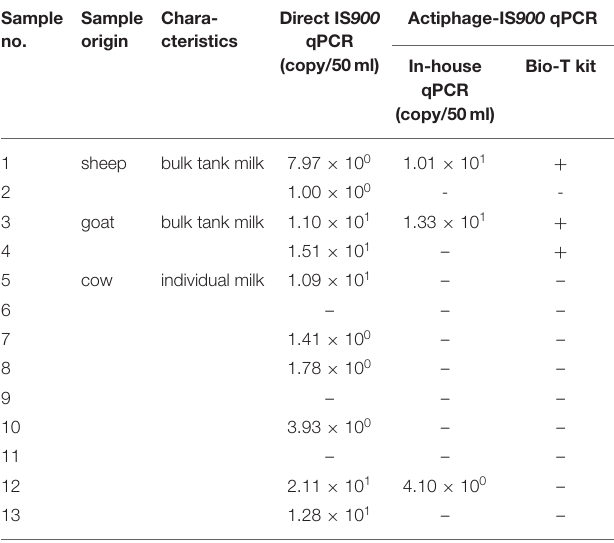
TABLE 2 | Comparison of the Actiphage-qPCR assay with direct IS 900 qPCR on fresh milk samples. Sample